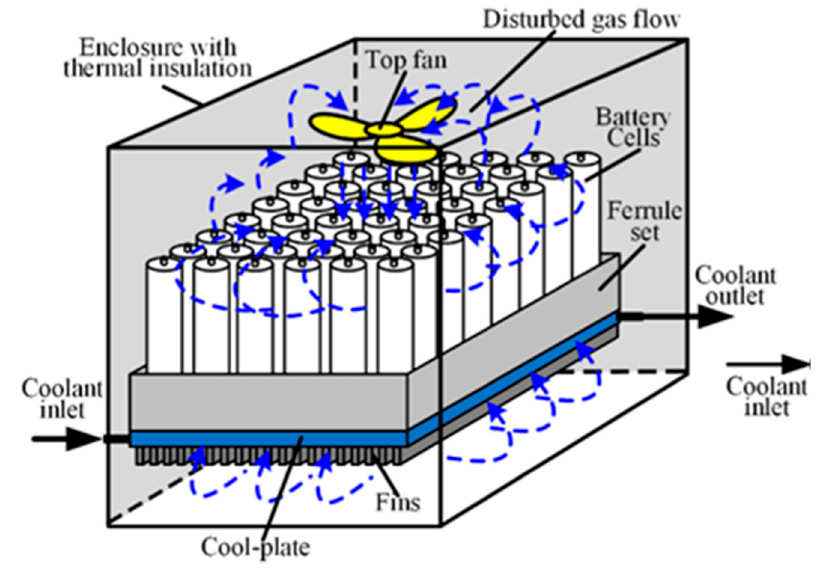
Figure 11. A classic example of BTMS based on liquid coupled with air. Reprint with permission [79]; 2020, Elsevier.